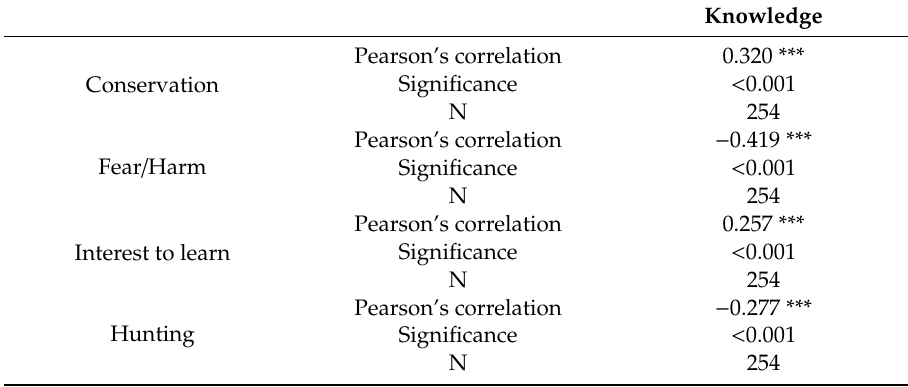
Table 4. Correlations between knowledge about and attitudes toward wolves. *** denotes p <